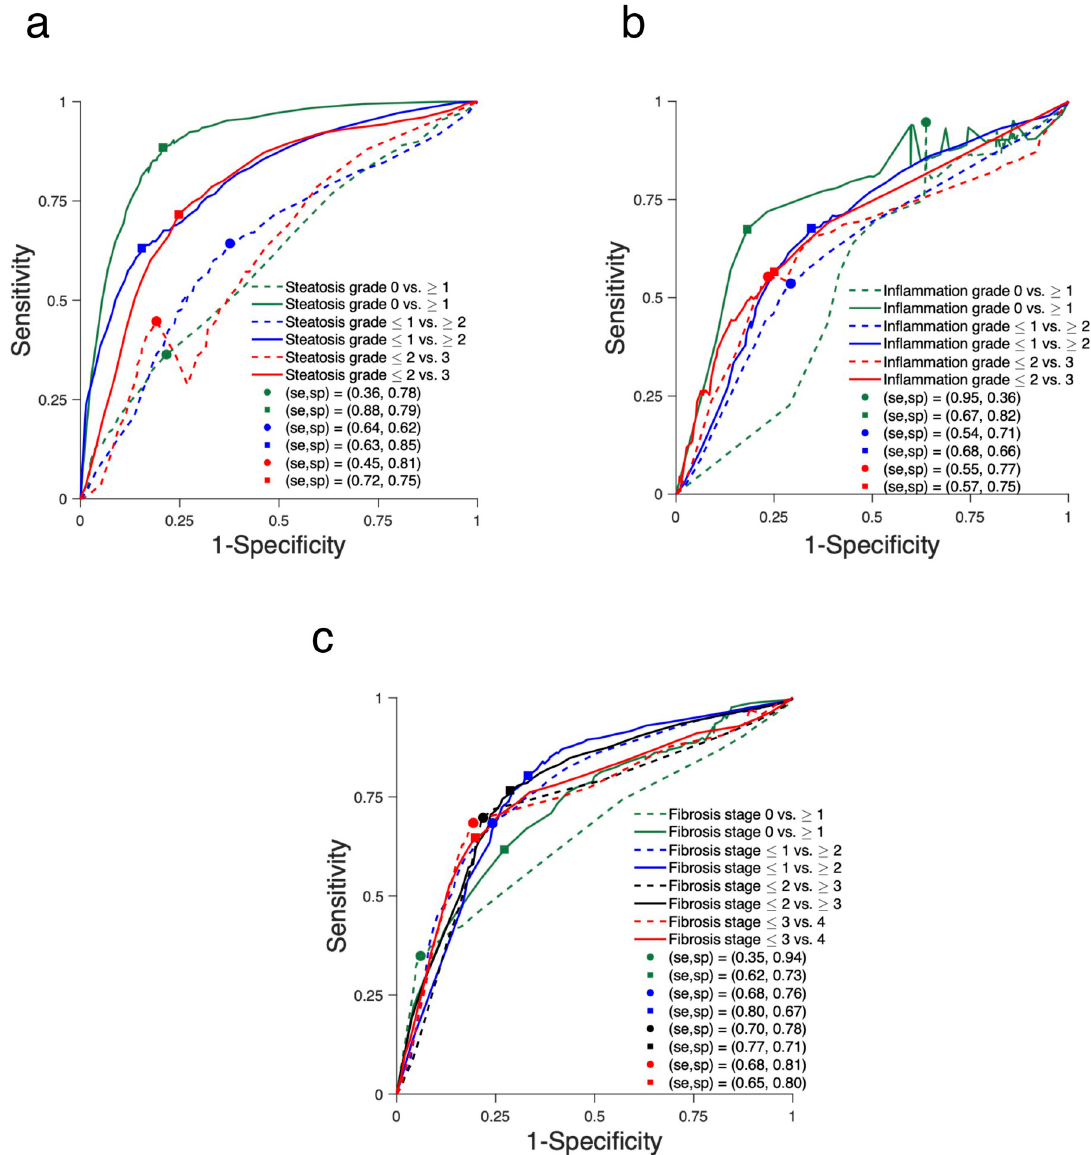
Fig 5. Receiver operating characteristic (ROC) curves. ROC curves obtained with elastography (dashed lines) and the combinations of QUS and elasticity features (solid lines) with highest AUC-ROC for the classification of (A) steatosis grade S0 vs. S1-3, S0-1 vs. S2-3, S0-2 vs. S3, (B) inflammation grade A0 vs. A1-3, A0-1 vs. A2-3, A0-2 vs. A3, and (C) fibrosis stage F0 vs. F1-4, F0-1 vs. F2-4, F0-2 vs. F3-4, F0- 3 vs. F4. Sensitivity and specificity at optimal Youden index are displayed for each ROC